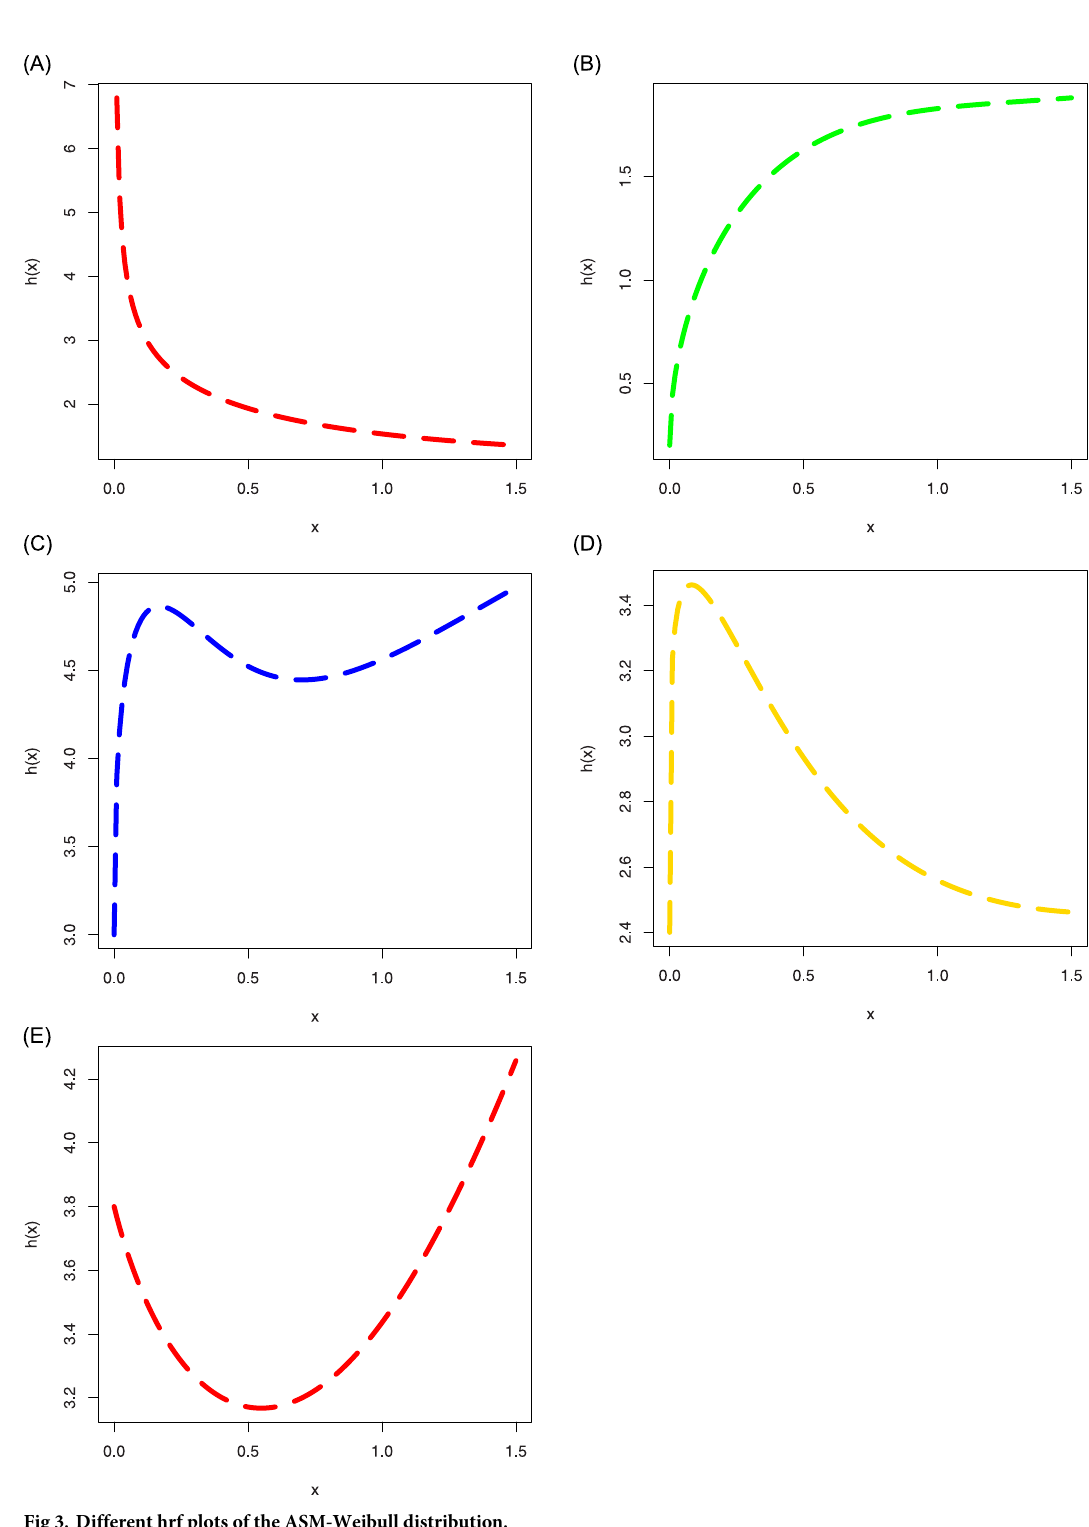
PLOS ONE | https://doi.org/10.1371/journal.pone.0254999 July 26,